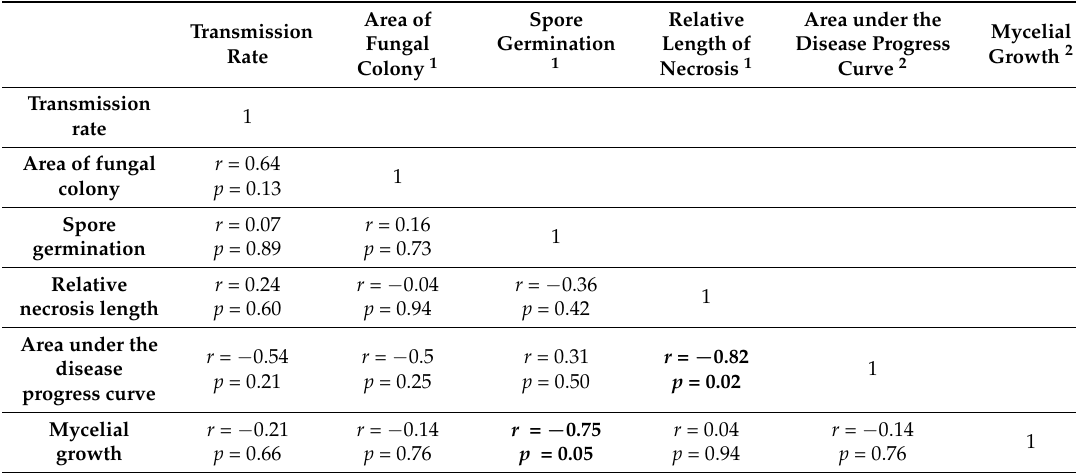
Table 2. Spearman correlation matrix for the variables under study. Correlations were considered significant at p < 0.05 (shown in bold type).